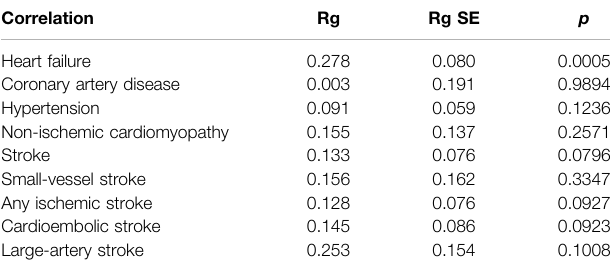
TABLE 1 | Genetic correlation between asthma and cardiovascular diseases. Correlation Rg Rg